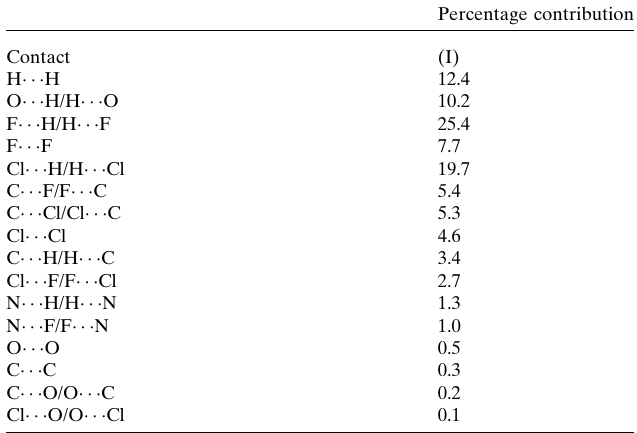
Table 3 Percentage contributions of interatomic contacts to the Hirshfeld surface for (I).